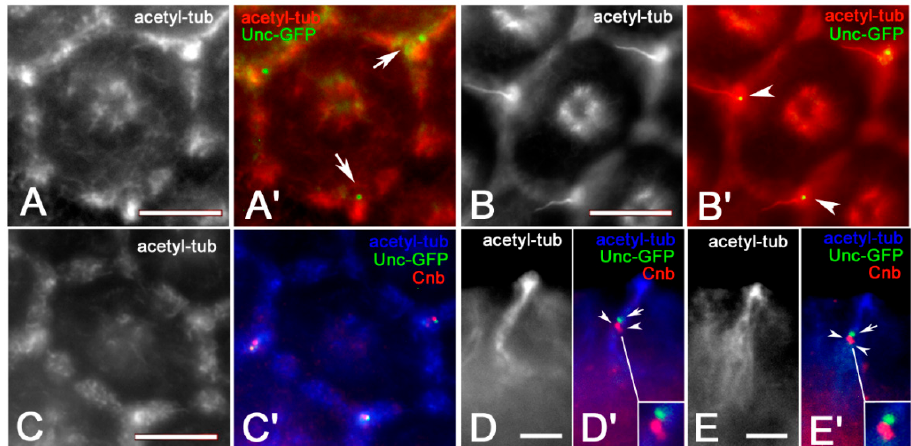
Figure 2. Localization of Unc-GFP in ommatidia at 25 ( A , A ′ ) and 45 ( B , B ′ ) hours APF: Only one Unc-GFP spot is associated with the bristle mother cells (arrows, A ′ ) and with the basis of the interommatidial bristles (arrowheads, B ′ ). ( C , C ′ ) The Unc-GFP spots do not overlap the centrobin (Cnb) staining in the bristle mother cells. ( D , D ′ , E , E ′ ) Longitudinal view of growing bristles showing one distal Unc signal (arrows) and two proximal centrobin spots (arrowheads). Scale bars: 5 µm ( A – C ), 2.5 µm ( D , E ).